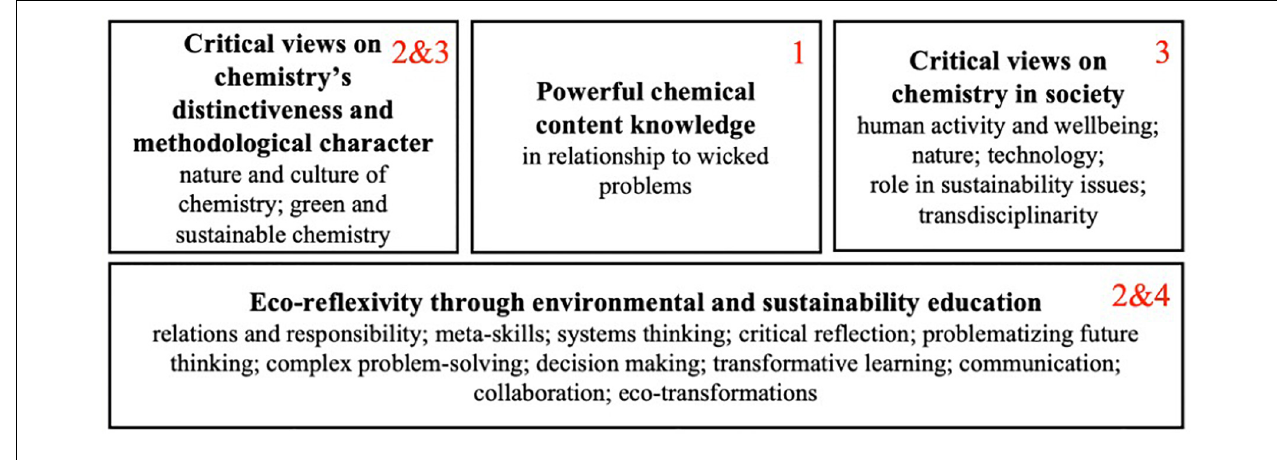
FIGURE 3 | Model linking student transformation of content for ChemoKnowings to four elements of Herranen et al.’s (2021) model viewed as important for ChemoKnowings. The context is ESE-framed chemistry education.